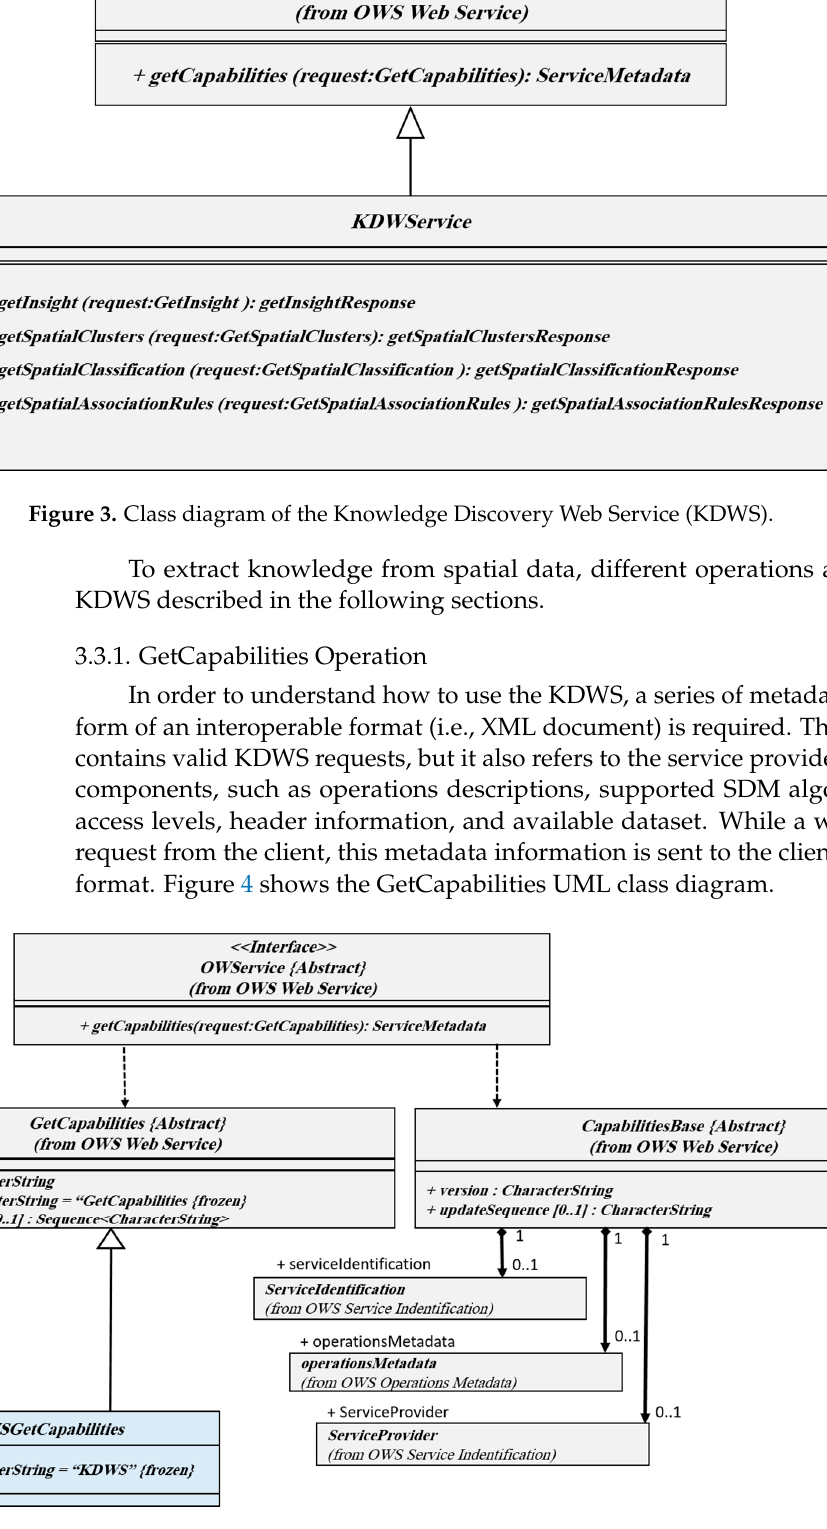
Figure 4. Interface of the GetCapabilities operation.